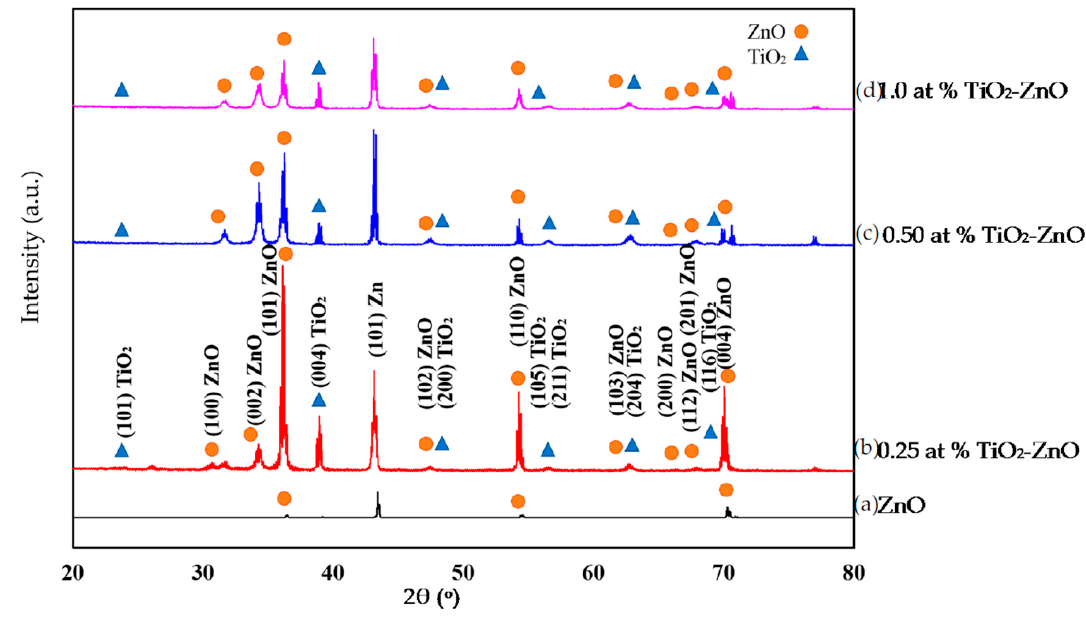
Figure 3. XRD pattern of ( a ) ZnO; ( b ) 0.25 at % TiO 2 -ZnO; ( c ) 0.50 at % TiO 2 -ZnO; and ( d ) 1.0 at % TiO 2 -ZnO.